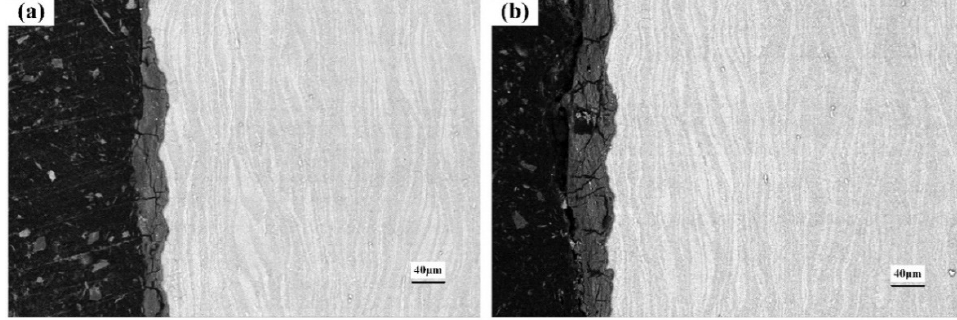
Figure 14. Cross-section morphology after corrosion in 1.0 mol/L Cl − solution: ( a ) 4 h; ( b ) 8 h; ( c ) 18 h; ( d ) 36 h. Figure 15. Thickness of the corrosion metamorphic layer in the different immersion tests . 4. Discussion 4.1. Corrosion Tendency Under the action of electrostatic force and surface energy, the space charge layer is generated at the interface of two phases, forming the double electric layer structure. The structure and charge distribution of the two-phase interface have great influence on the electrochemical corrosion process. A double-layer electrostatic model called GCS is established. ZK61M alloy with a smooth surface is placed in Cl - solution, and the basic structure of its ideal interface struc- ture can be obtained, as shown in Figure 16a. There are a lot of free electrons in the mag- nesium alloy. When a small amount of residual charge is concentrated at the interface, the distribution of free electrons is not disturbed. The remaining charges in the magnesium alloy are tightly arranged, and the potential at each point in the alloy is equal. Figure 16b